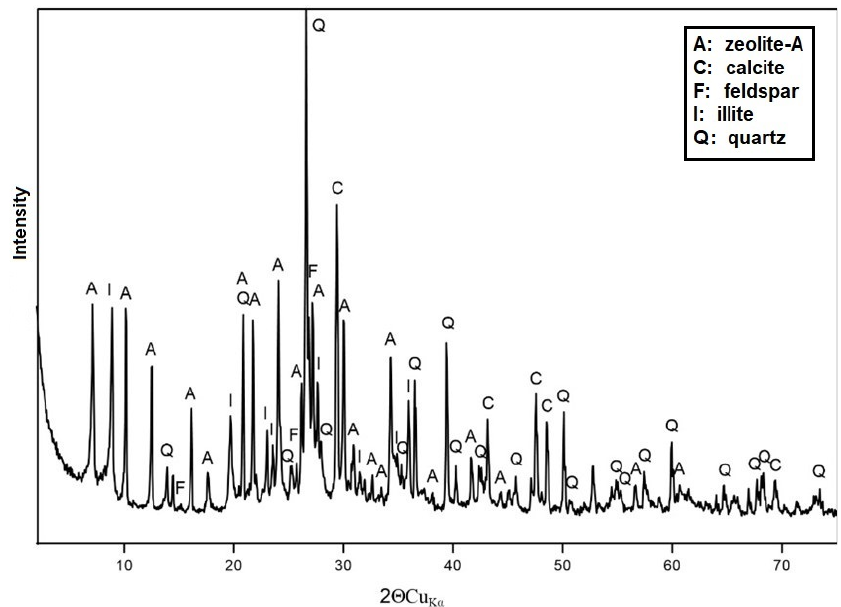
Figure 5. Diffractogram of sample RM.